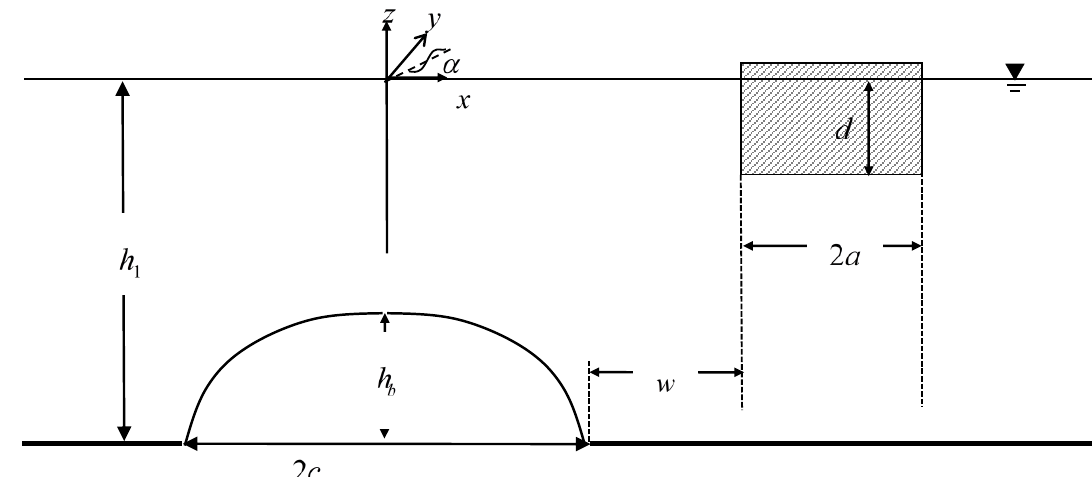
Figure 5. Schematic diagram of the water-wave-scattering by a rectangular surface-piercing structure behind a parabolic breakwater.